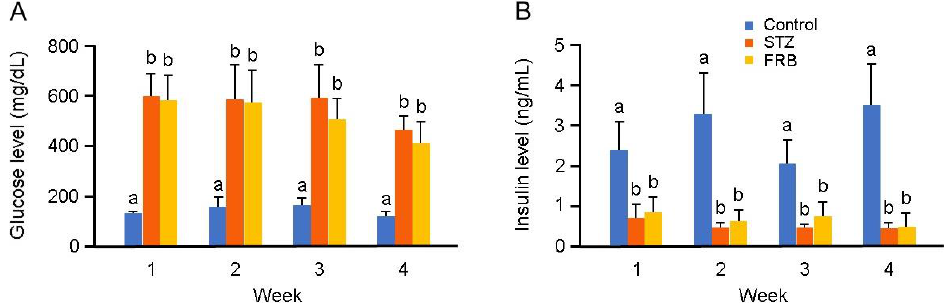
Figure 2. One-month supplementation of FRB could not recover the effect of STZ on hyperglycemia and hypoinsulinemia. ( A ) Blood glucose level; ( B ) plasma insulin level. Data are shown as the means + SEM. Significance ( p < 0.05, n = 5 – 6) among groups is denoted by different letters (a, b).